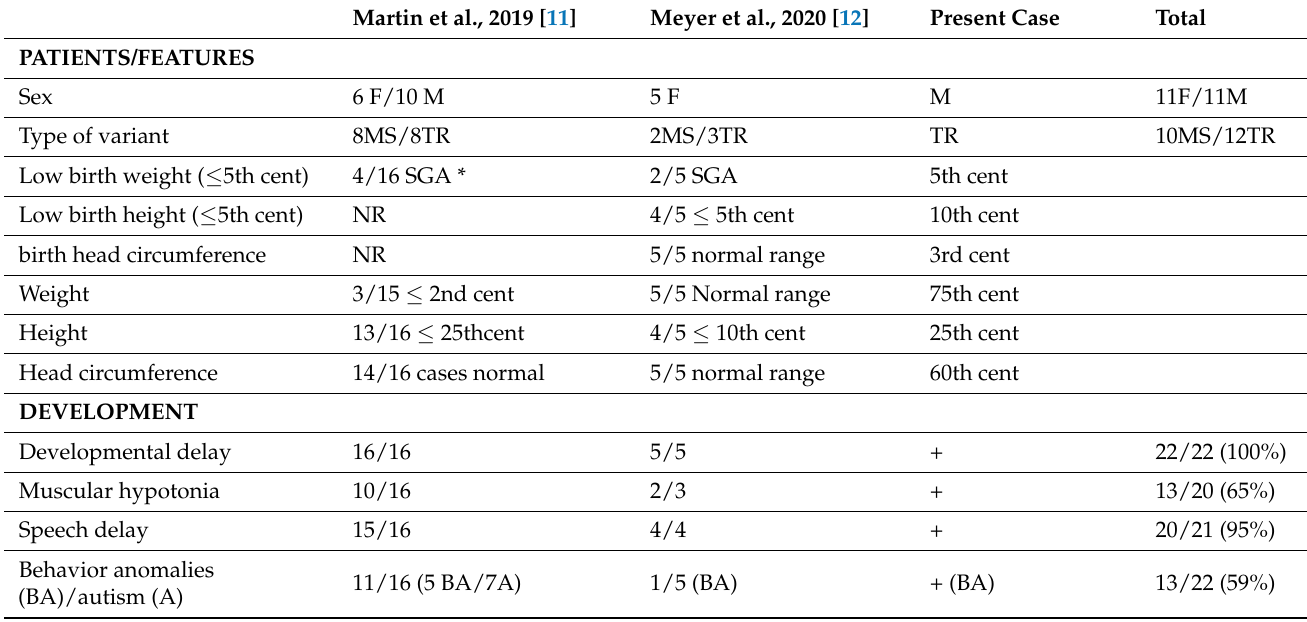
Table 1. Clinical signs and facial features in intellectual developmental disorder with speech delay, autism, and dysmorphic facies